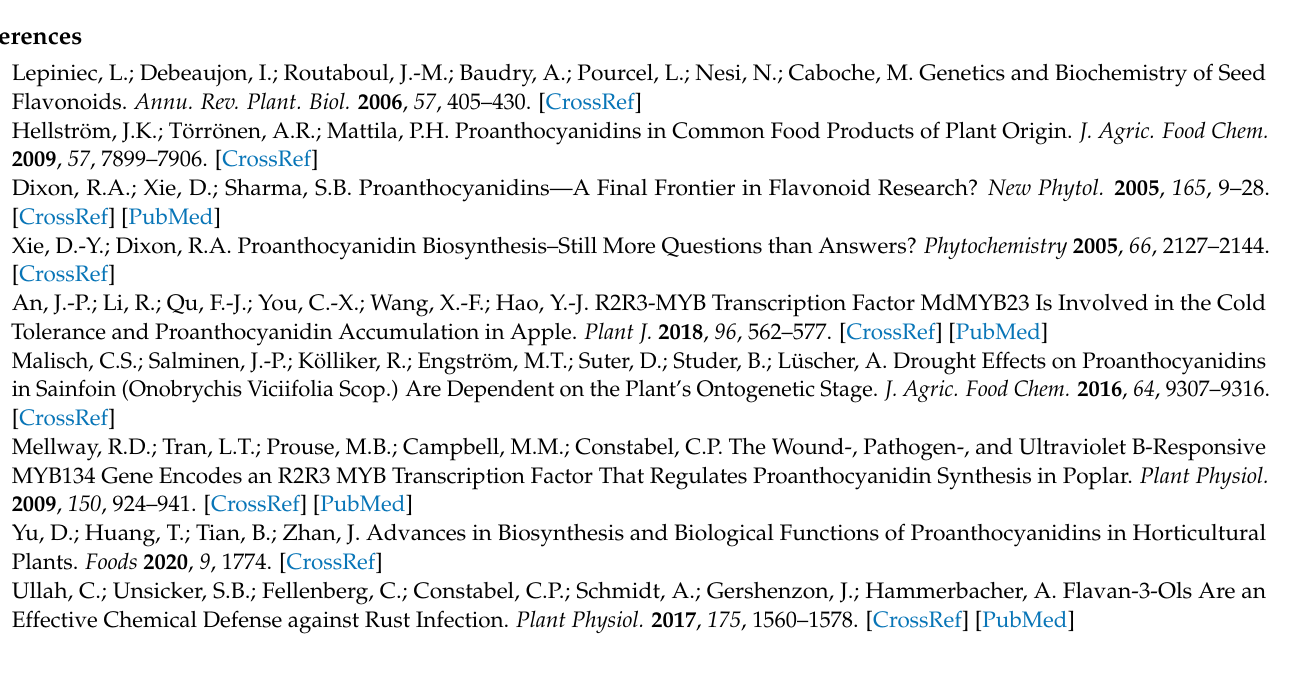
Table S2: Identification of orthologous genes involved in PAs biosynthetic